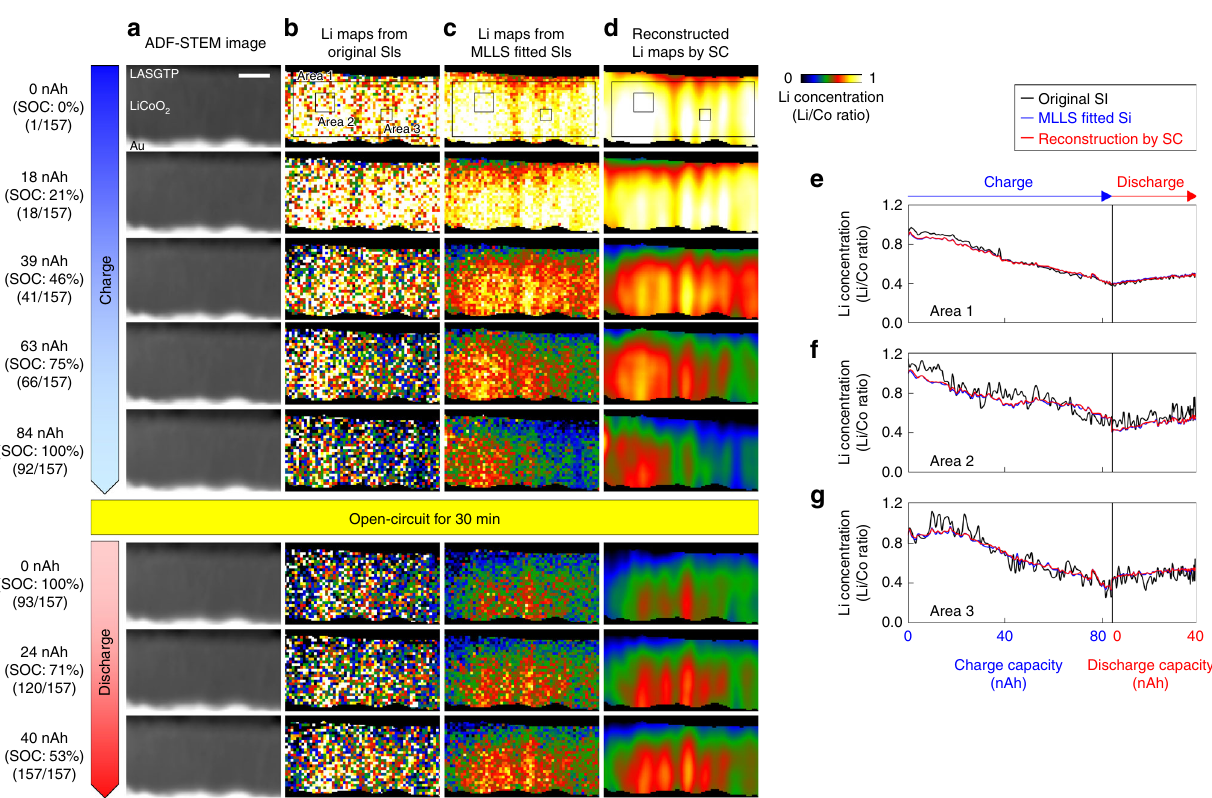
Fig. 4 Comparison of the original and denoised Li maps during the electrochemical reactions. a – d Part of the time series of 157 a ADF-STEM images, b Li maps obtained from the original SI, c Li maps obtained from the MLLS- fi tted SI, and d Li maps obtained by SC reconstruction. e – g Changes in the average Li concentrations in the areas indicated in b – d . The results indicated that MLLS fi tting and SC reconstruction ef fi ciently denoised and super-resolved without producing serious artefacts. The scale bar in a is 100